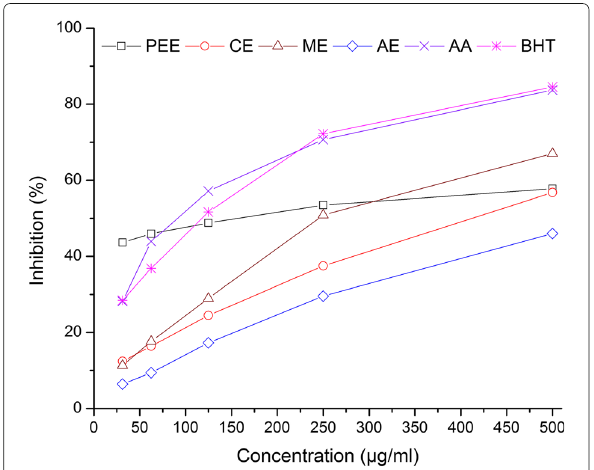
Fig. 1 DPPH radical scavenging activity of different extracts of C. pallida stem and standard antioxidants. All tests were done three times. PEE-Petroleum ether extract, CE-Chloroform extract, ME-Methanol extract, AE-Aqueous extract, AA-Ascorbic acid, BHT-Butylated hydroxytolune